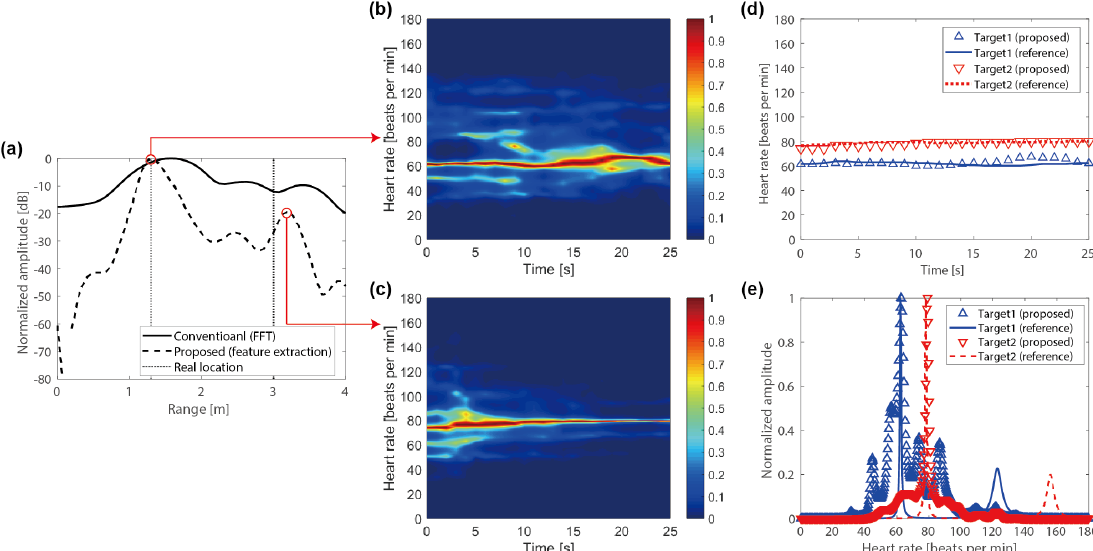
Figure 9. Measurement results for a single person at a distance of 300 cm: ( a ) range estimation; ( b ) heart rate and respiration; and ( c ) range estimation varying with distance from the radar.